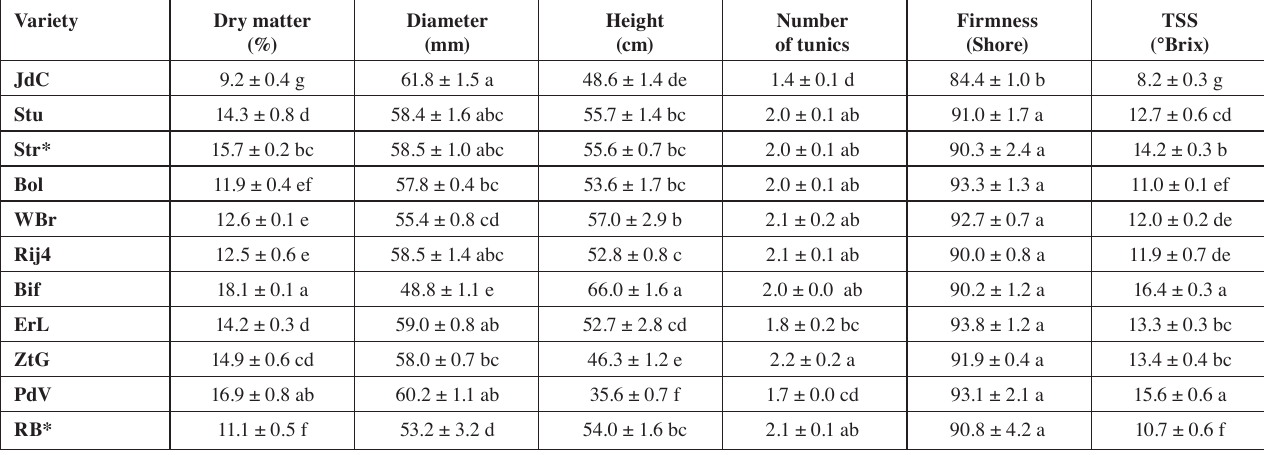
Tab. 3: Morphological parameters of onion